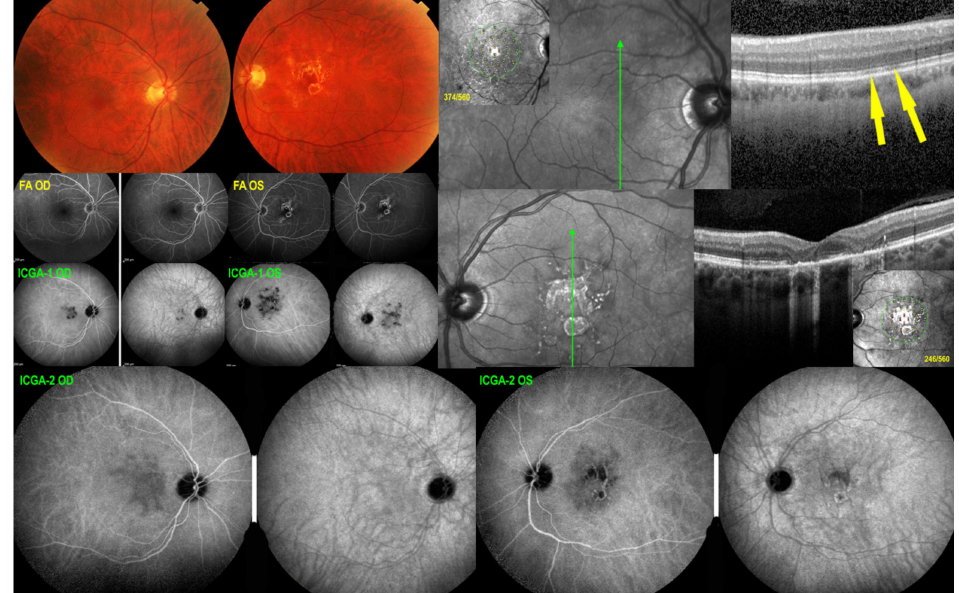
Figure 16. Serpiginous choroiditis. SC at first presentation. Fundus ( top left ) shows a normal posterior pole OD and a central chorioretinal scar OS. SD-OCT OD ( top right ) shows only faint IS/OS interruption (yellow arrows) with a slightly diminished retinal sensitivity (insert: microperimetry value 374/560, see Figure 19). SD-OCT OS ( middle right ) shows numerous zones of damage to the photoreceptor outer segments and total chorioretinal atrophic areas with markedly diminished retinal sensitivity (insert: microperimetry value 246/560, see Figure 19). FA OD appears as normal, and FA OS shows the chorioretinal scar (hyperfluorescent window effect). ICGA-1 OD shows occult hypofluorescent areas of choriocapillaris non-perfusion while ICGA-1 OS shows hypofluorescent areas that extend beyond the chorioretinal atrophic areas indicating additional occult non perfusion. After 3 sub-Tenon’s injection bilaterally, ICGA-2 OD shows decrease of hypofluorescence indicating reperfusion especially on the late frame ( right ). Similarly, ICGA-2 OS shows decrease of hypofluorescence in the areas around the central chorioretinal atrophic area indicating reperfusion of these